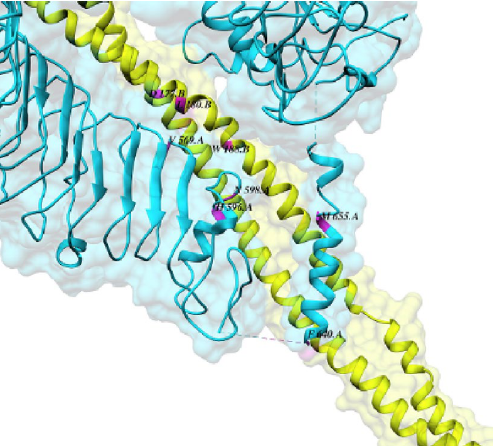
Figure 7. The interaction site of the designed vaccine and toll-like receptor 5 (TLR5) was analyzed by the PPCheck tool. The TLR5 is represented as cyan ribbons (chain A), the designed vaccine is illustrated as green color (chain B), and the interacting residues are in magenta. The residues are labeled, indicating the actual residue number of the structures and the relative chains.